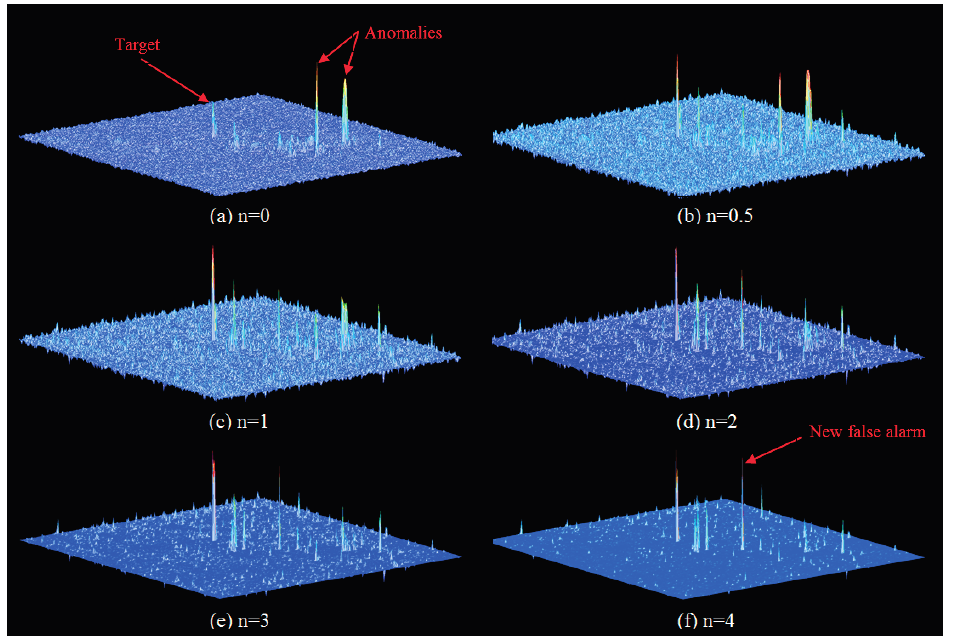
Figure 3. 3-D plots of the detection results for the HyMap dataset by implementing different weight n in ASMF.